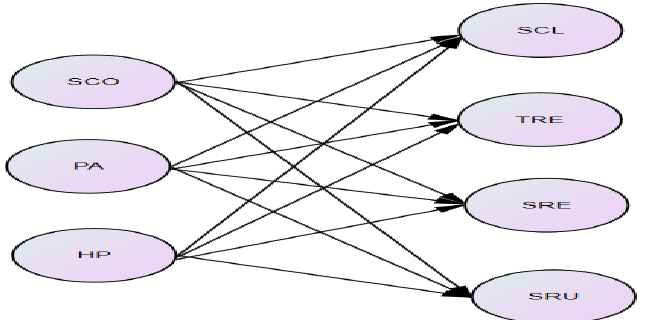
Figure 1. Variables in multiple regression. Independent variables: sports competence (SCO), physical activity (PA), health promotion (HP); dependent variables: school class (SCL), teacher relationship (TRE), schoolmate relationship (SRE), school rules (SRU).